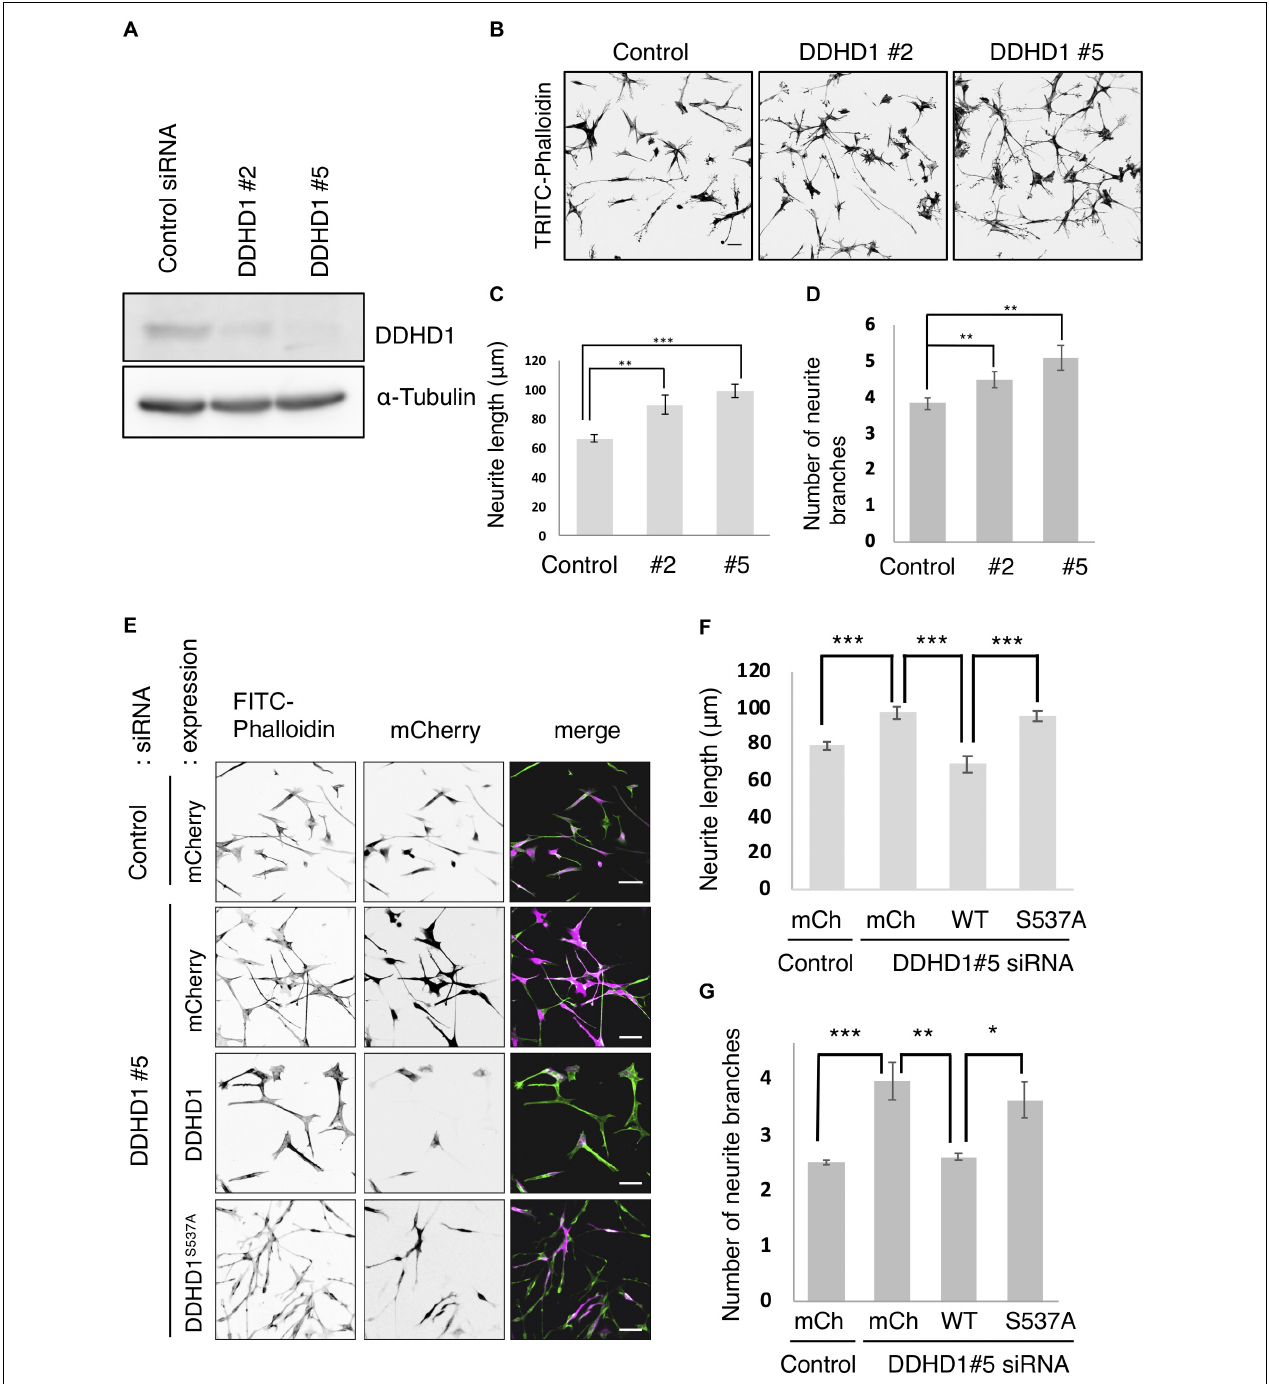
FIGURE 1 | Knockdown of DDHD1 induces enhanced neurite outgrowth in SH-SY5Y cells. (A) SH-SY5Y cells treated with luciferase siRNA (control siRNA), DDHD1 siRNA#2, or DDHD1 siRNA#5 were analyzed by Western blotting with the indicated antibodies. (B) At 72 h after siRNA transfection, SH-SY5Y cells were subjected to RA treatment for 72 h to induce neurite outgrowth. The cells were fixed and stained with TRITC-phalloidin. Scale bars, 50 µ m. (C,D) Quantification of the data in (B) . The graph shows the average length of the longest neurite tubule (C) and the number of neurite branches (D) in each cell. (E) SH-SY5Y cells were treated with DDHD1 siRNA#5 or control siRNA for 48 h, and then infected with the indicated retroviruses. At 24 h after infection, the cells were treated with RA for 72 h. The fluorescent signals for FITC-phalloidin, mCherry and merged image are shown. Scale bars, 50 µ m. (F,G) Quantification of the data in (E) . The average length of the longest neurite tubule (F) and the number of neurite branches (G) in each cell was measured and is shown in the graph. At least 50 cells were measured in each experiment. Statistic values are expressed as means for three independent experiments ± S.D. * p < 0.05; ** p < 0.01; *** p < 0.001 (Tukey test).